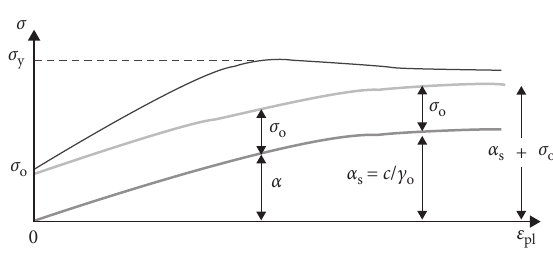
Figure 1: Simplified 1D representation of the